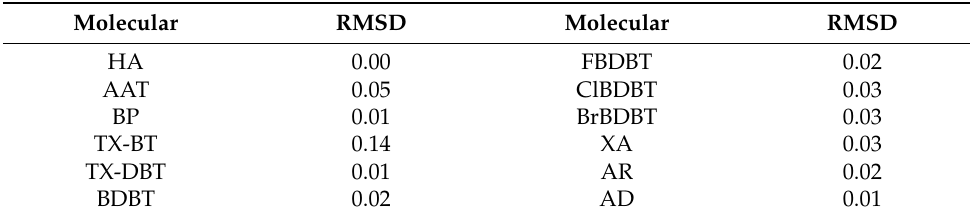
Table 1. The root mean square deviation (RMSD) in Å of the two AQs geometries that were optimized by TDDFT and UDFT, respectively. Molecular RMSD Molecular RMSD HA